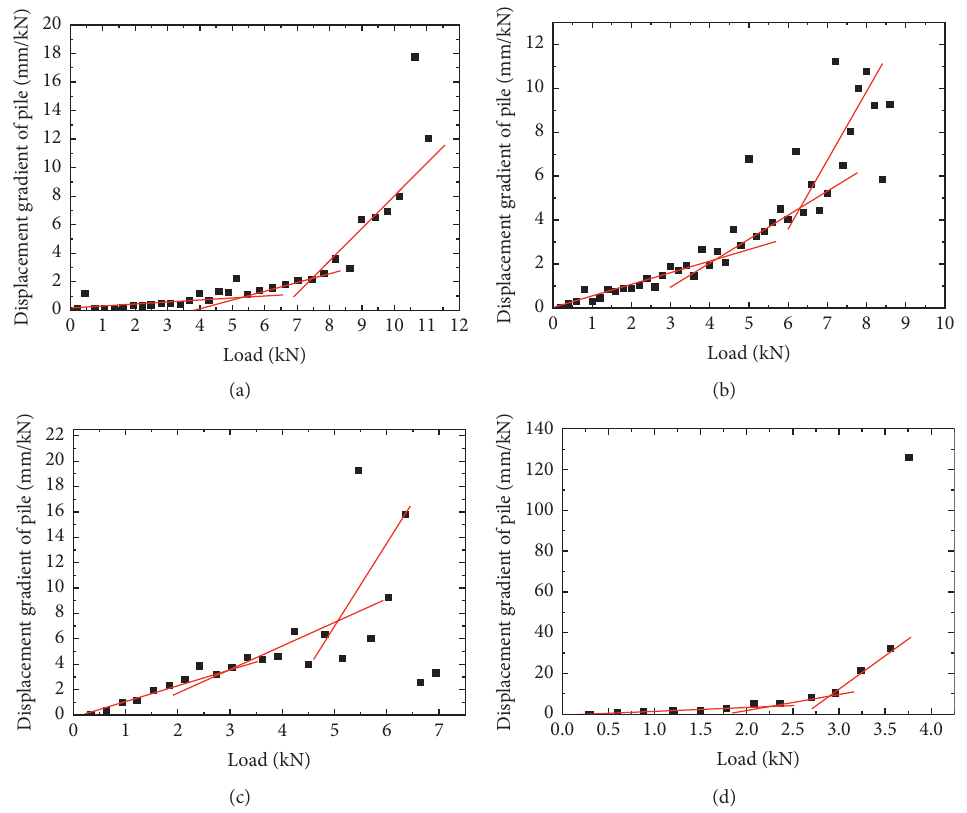
Figure 9: Horizontal load-displacement gradient curve of pile. (a) 0 ° slope, (b) 0 ° slope, (c) 0 ° slope, and (d) 0 ° slope.